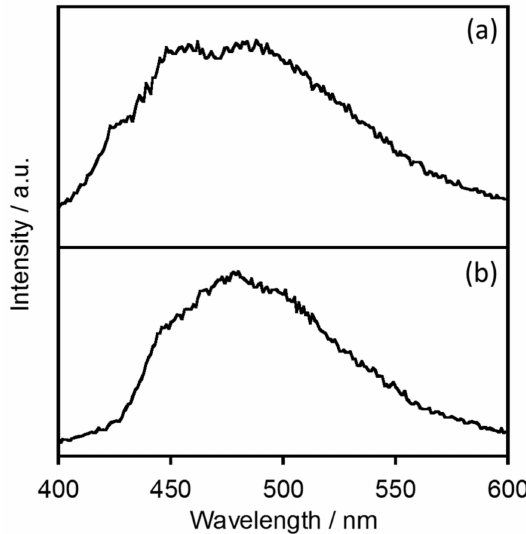
Figure 4. Phosphorescence spectra localized on the ligand moiety of helical Gd complex with L in ( a